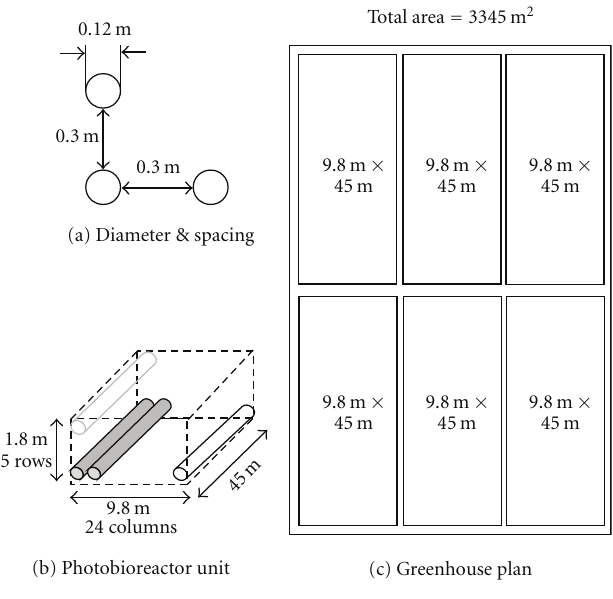
Figure 4: Photobioreactor system layout (not to scale). Table 2: Summary of photobioreactor and greenhouse